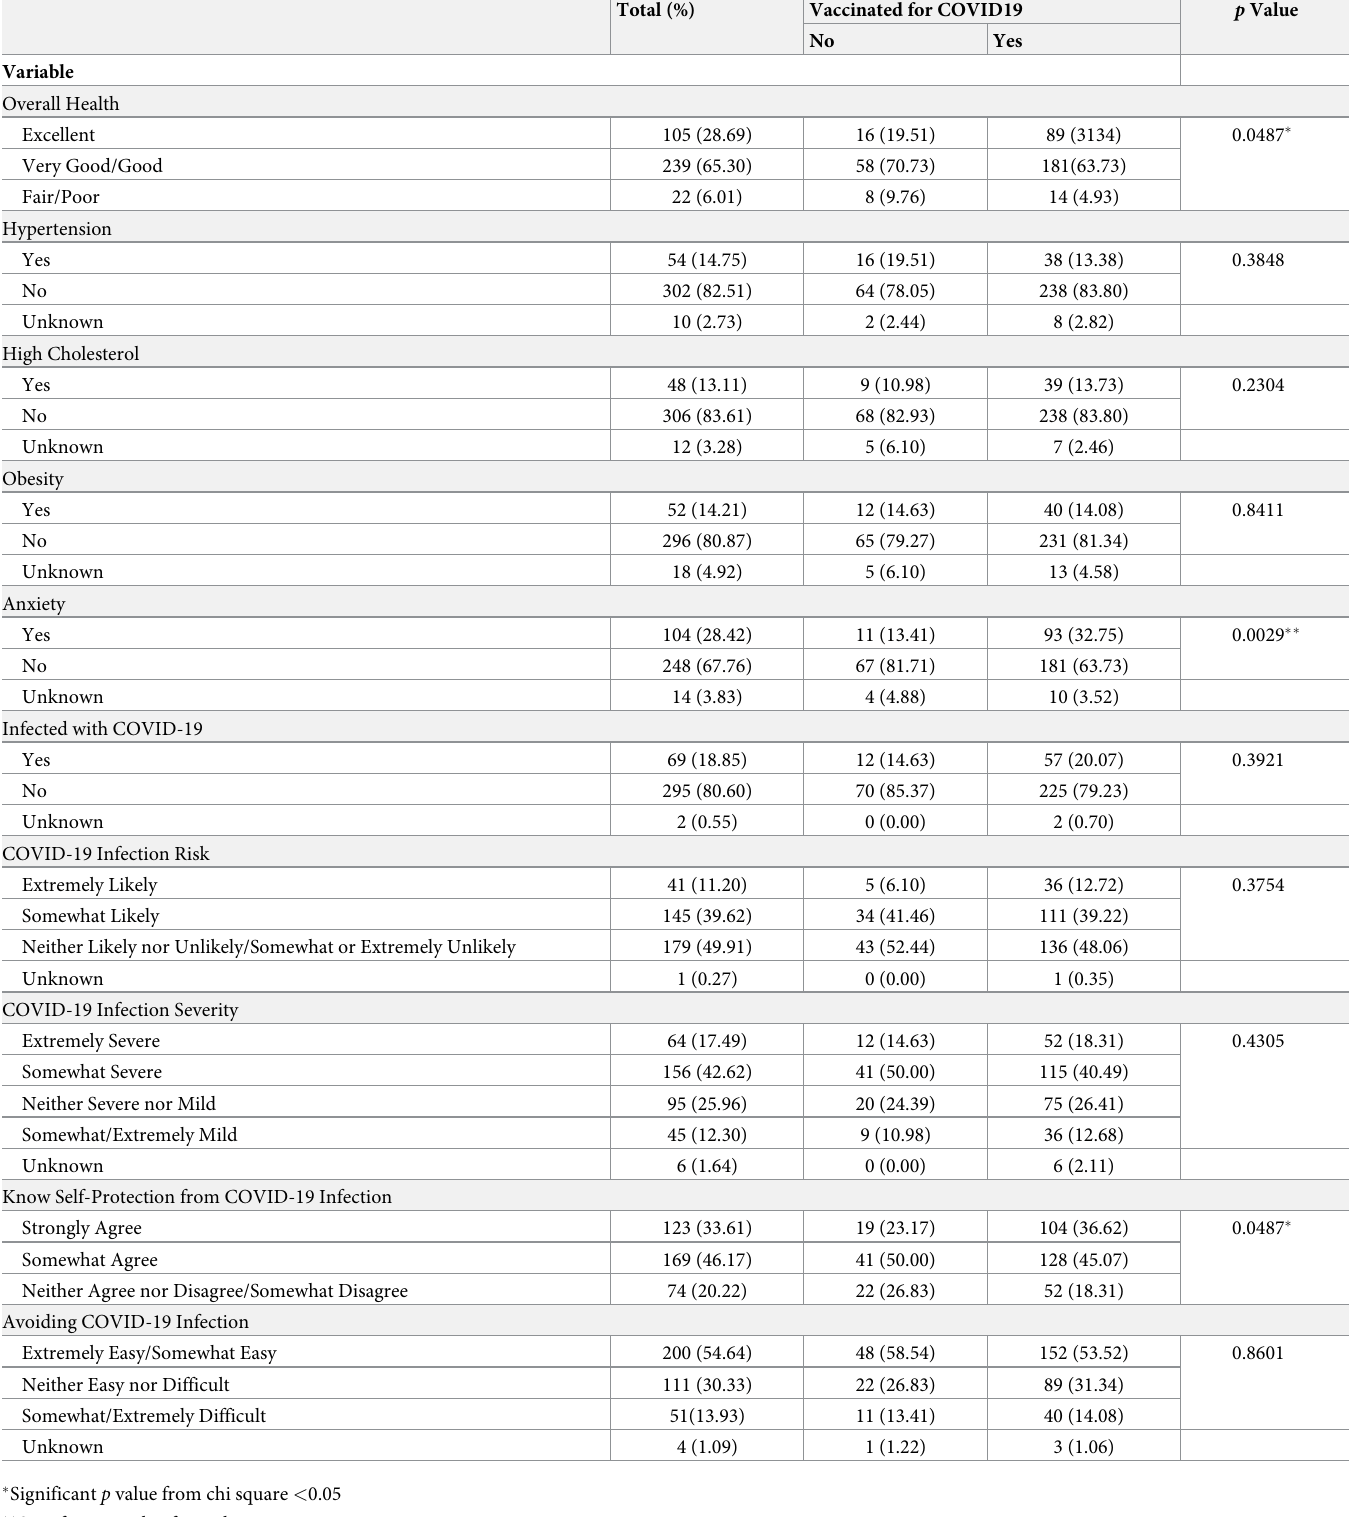
Table 2. Baseline health characteristics and COVID-19